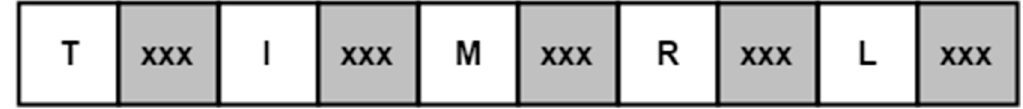
Figure 6. Data packet structure.